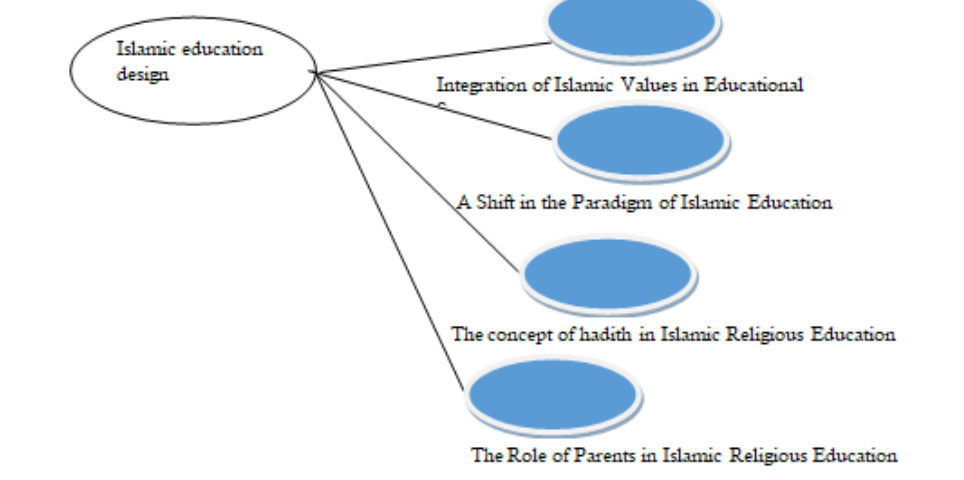
Figure 1 Islamic Religious Education Design Project